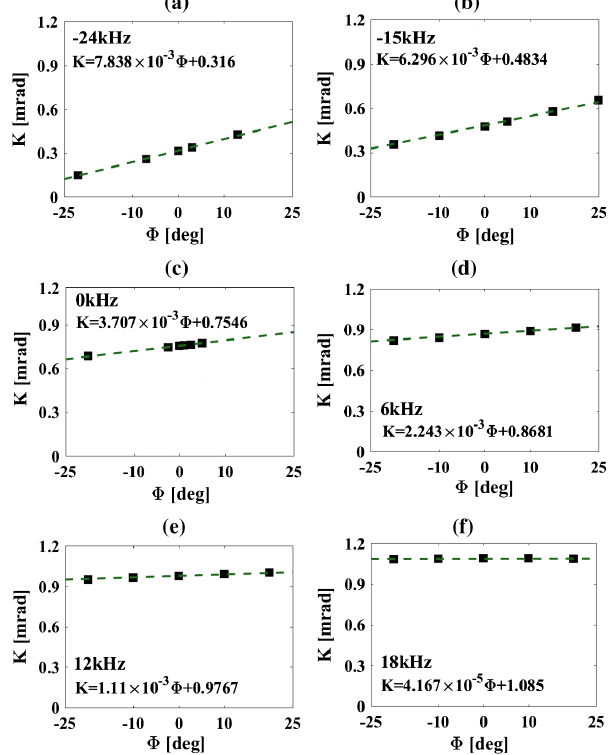
FIG. 9. Simulated phase slopes of the kick vs Δ f . Green lines: linear fits to the simulation results. Φ : gun phase w.r.t. MMMG.